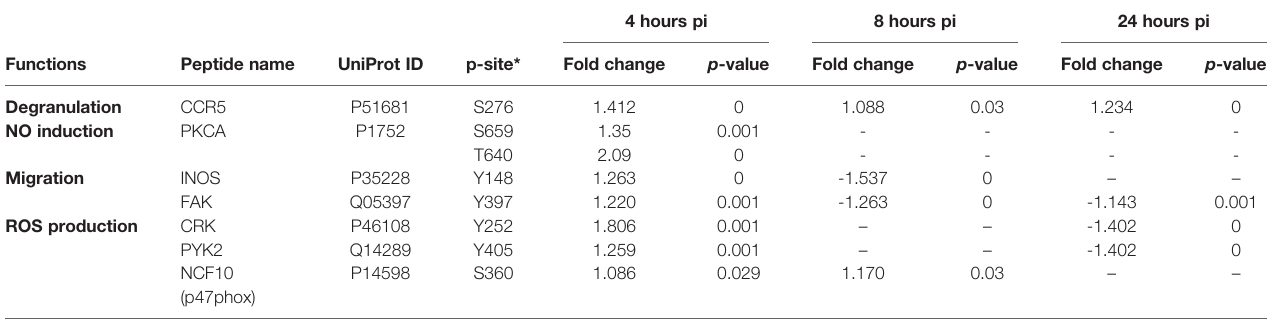
TABLE 6C | Members of the chemokine signaling pathway showing differential phosphorylation between Salmonella enterica serovar Enteritidis-infected cecal tissue and non-infected cecal tissue: CCR5P-PLC-PKC signaling pathway.